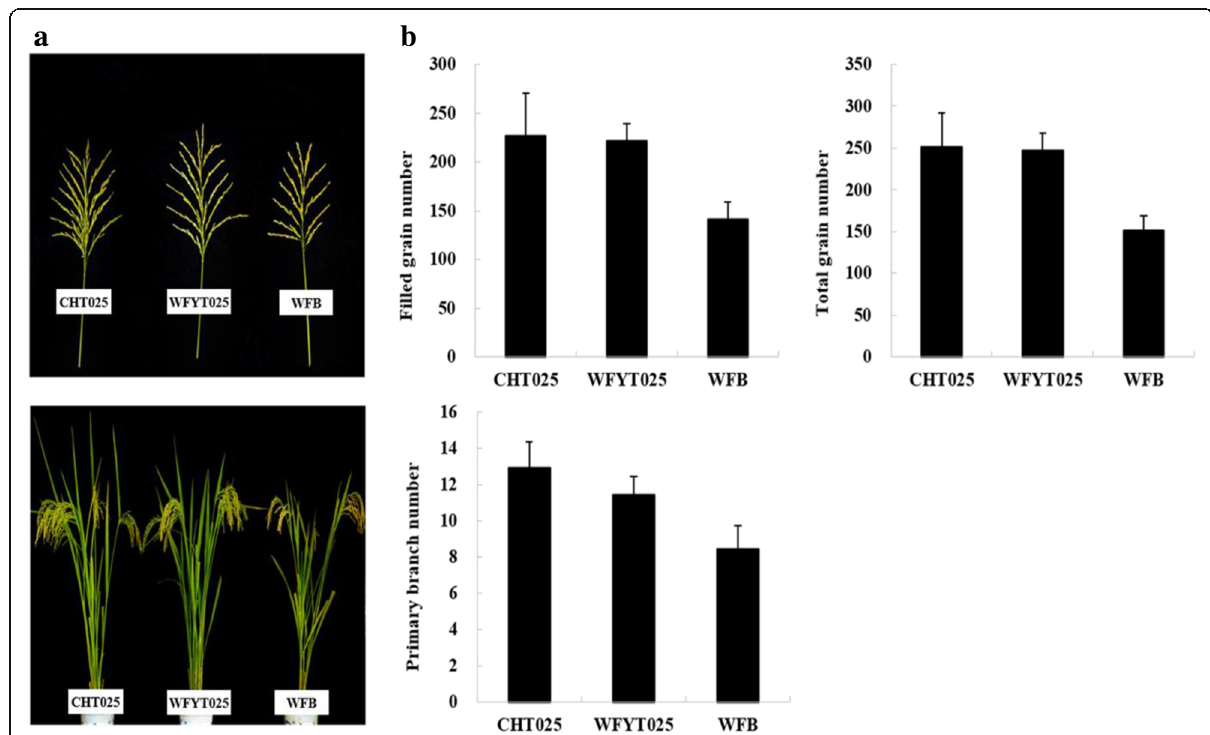
Fig. 1 Comparisons of super hybrid WFYT025 combination. a The upper panel illustrates the panicles from combination of super hybrid WFYT025. Left, CHT025; middle, WFYT025; right, WFB. The lower panel shows the combination of super hybrid WFYT025. Left, CHT025; middle, WFYT025; right, WFB. b Panicle traits of CHT025, WFYT025, and WFB